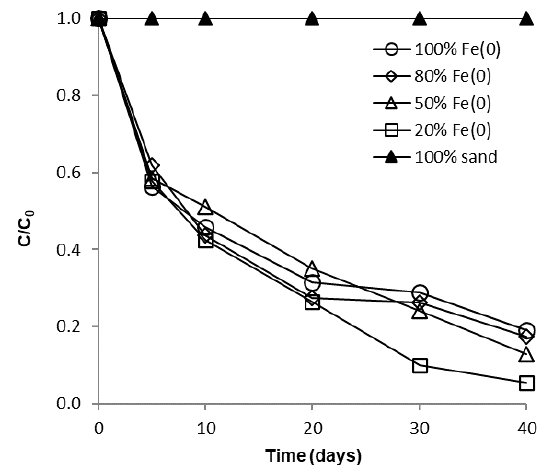
Figure 4. Time profile of Cr VI removal for batch experiments at low initial concentration.